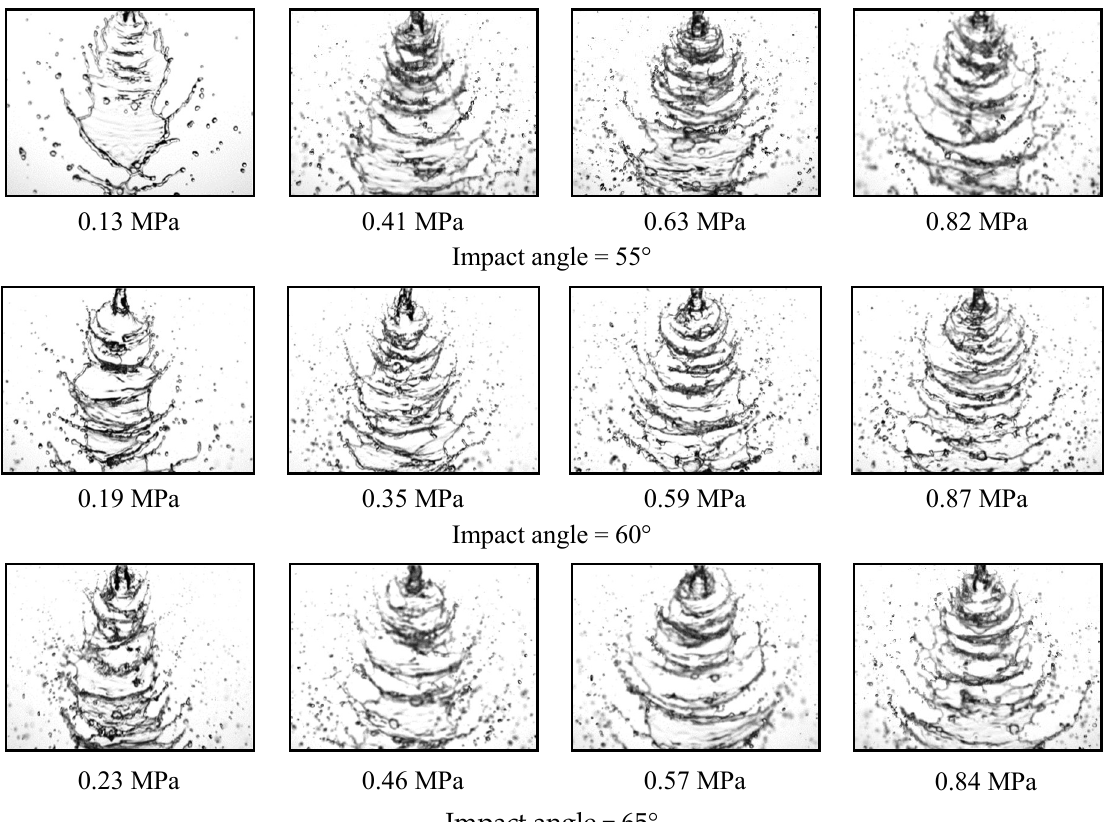
Figure 10. Atomization field morphology of double jets with a 1 mm diameter nozzle at different impact angles under different injection pressures.